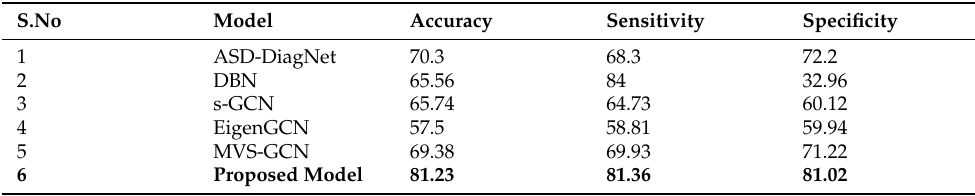
Table 4. Comparison of the Proposed Model with State-of Art